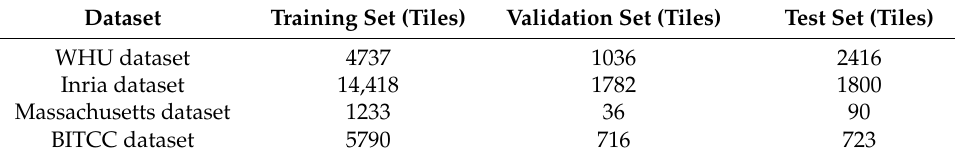
Table 2. Settings used for each dataset in the